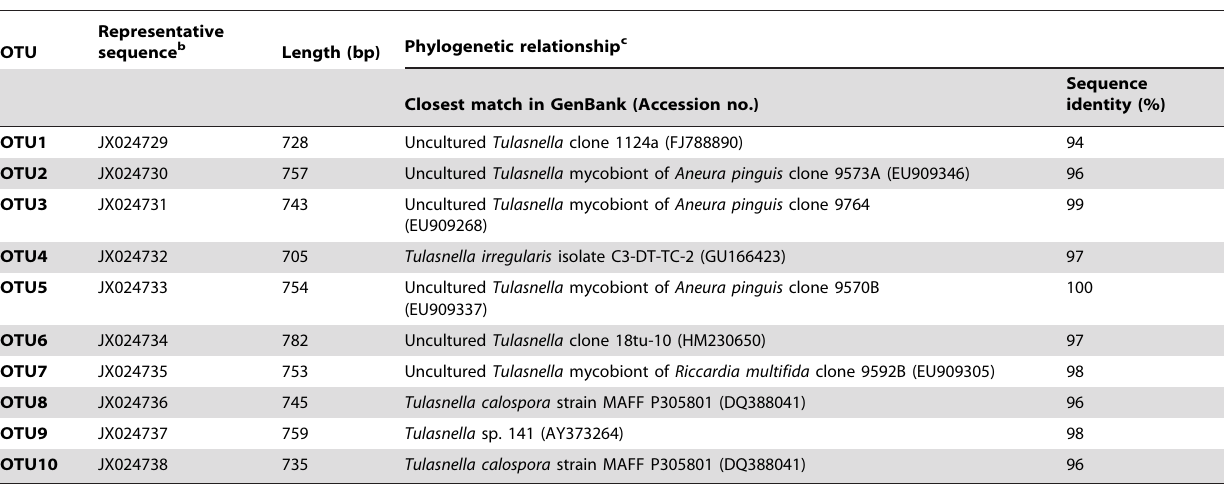
Table 1. List of fungal operational taxonomic units (OTUs) a identified using cloning and sequencing.